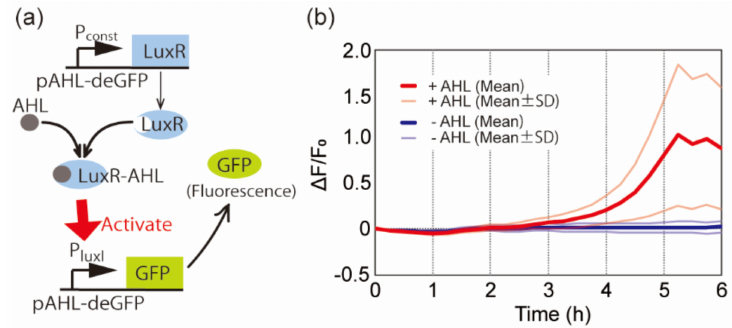
Figure 3. Protein synthesis using freeze-dried CFPS system and freeze-dried DNA. ( a ) Schematic diagram of the gene circuit demonstrated in ( b , c ). ( b ) Time-lapse fluorescent images of the repre- sentative microchamber freeze-dried together with the DNA shown in ( a ). The scale bar is 100 µm. ( c ) Time-course of the fluorescent intensities in the microchambers with (+DNA) or without DNA ( − DNA). SD shows standard deviation ( n ≧ 3 each). The freeze-drying condition of the microflu- idic device was ~30 mTorr, − 80 °C, 6 h.